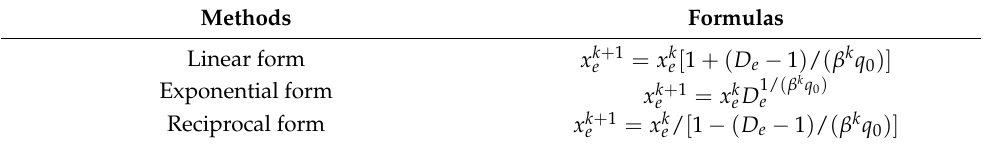
Table 2. Design variable update